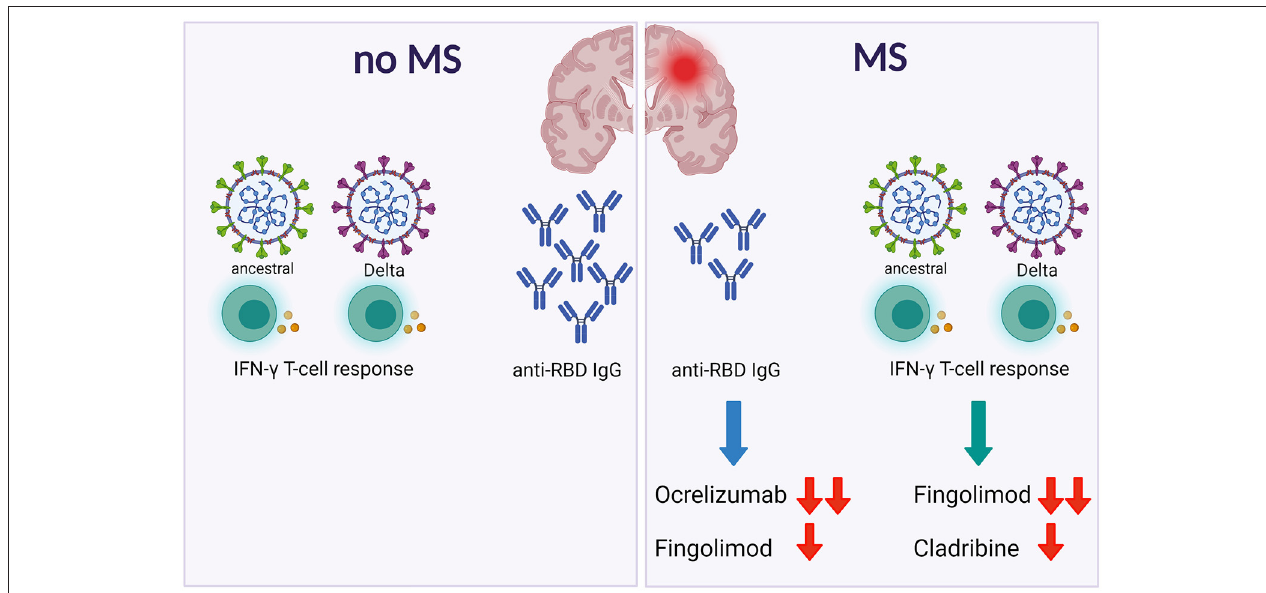
FIGURE 2 | Patients with MS show a specific spike T-cell response to both ancestral or Delta SARSCoV-2. However, DMTs differently affect the antibody and the T-cell responses. Footnotes: MS, Multiple Sclerosis; IFN, Interferon; RBD, Receptor Binding